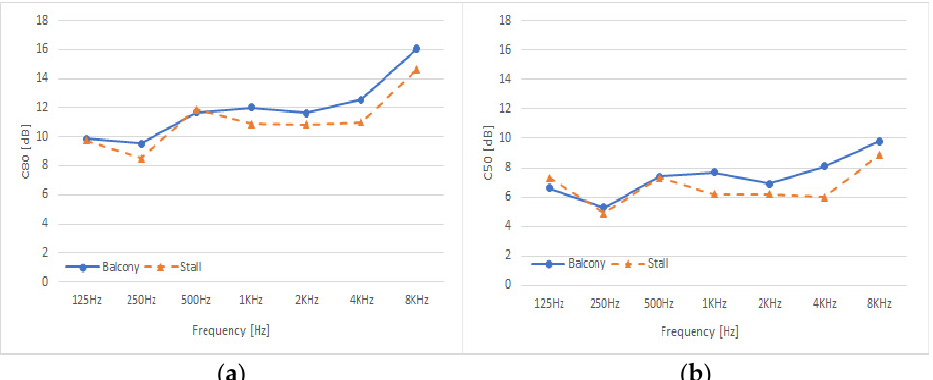
Figure 10. Measurements results of the acoustic parameters: Clarity indexes (C 80 ) ( a ) and Clarity indexes (C 50 ) ( b ).